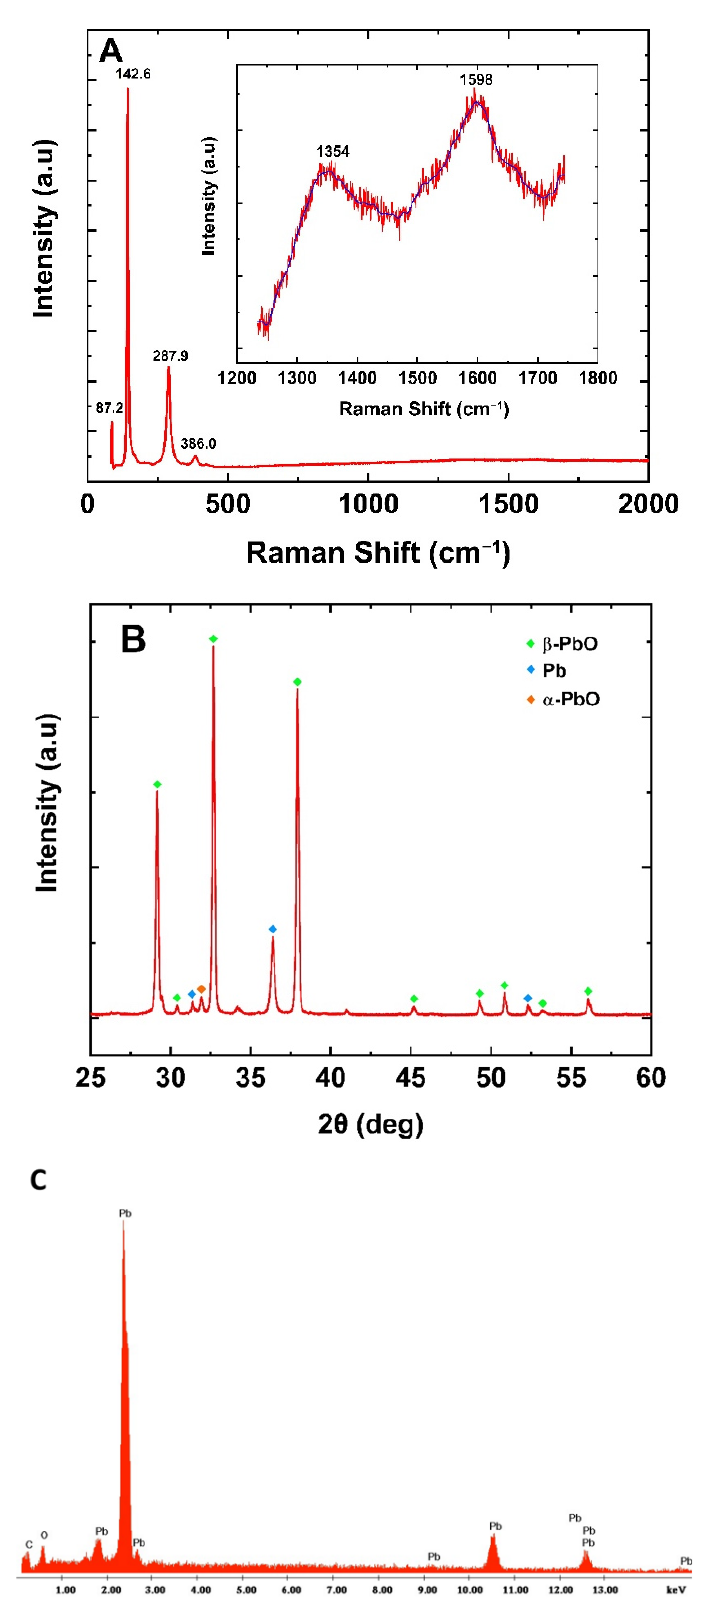
Figure 3. ( A ) Raman spectrum, ( B ) XRD pattern, and ( C ) EDS spectrum of the electrode surface after the deposition of rGO.